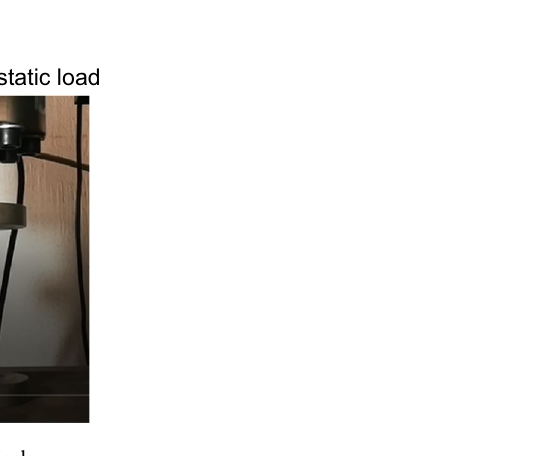
Figure 4. Experimental setup used in this